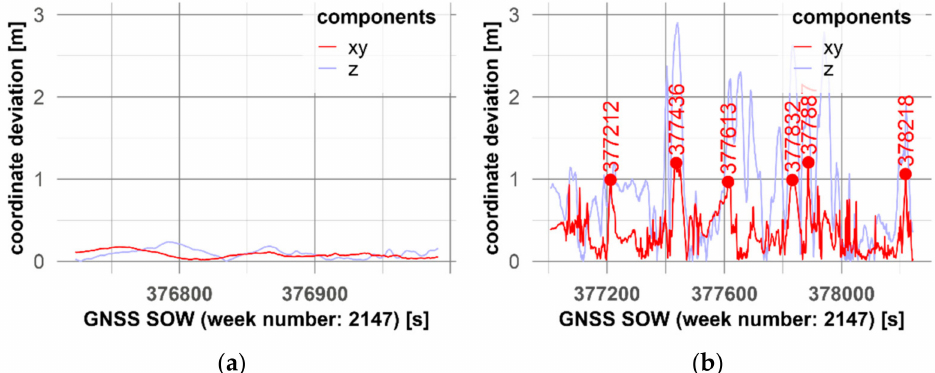
Figure 10. Coordinate deviations between the low-cost data capturing system and the BIMAGE backpack reference systems as a function of time in GNSS Seconds of Week (SOW). Two time periods with different conditions were investigated: ( a ) static data recording with good GNSS reception; ( b ) dynamic data recording with different GNSS